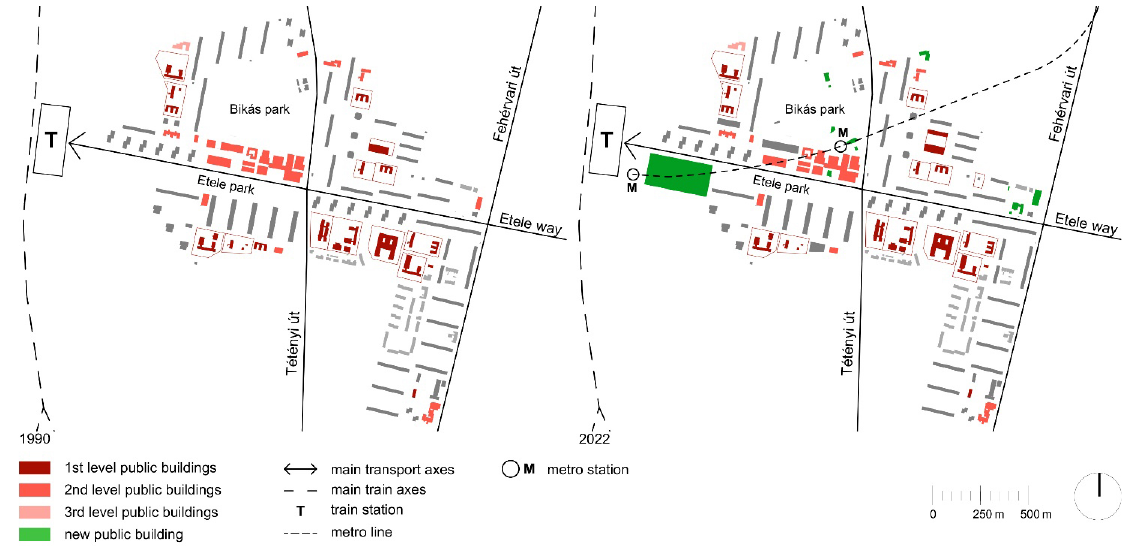
Figure 10. Kelenföld public buildings in 1990 and 2022 (source: